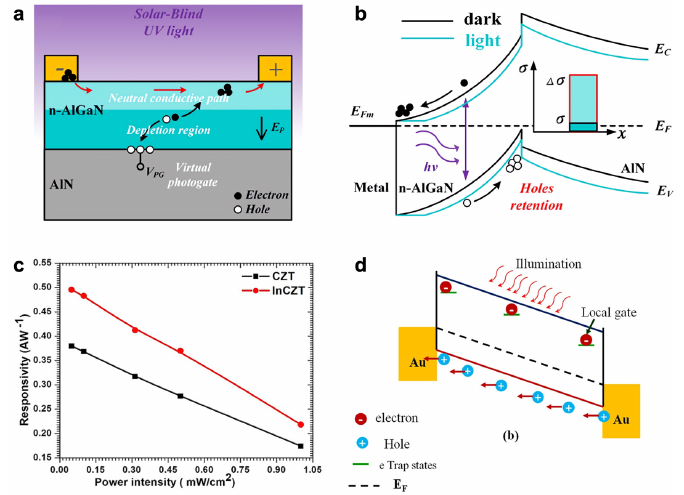
Figure 4. Inorganic compound-based photodetector. ( a ) Schematic diagram of an Al 0.5 Ga 0.5 N ∕ AlN solar-blind UV photodetector and its neutral conductive path under DUV irradiation. ( b ) Schematic diagram of the energy band under dark and illumination conditions. ( c ) Measured and fitted pho- tocurrent of a CZT- and InCZT-based device under different intensities of light irradiation. ( d ) Sche- matic of the band diagram of the device under light illumination. ( a , b ) Reproduced with permission from [113]. Copyright Chinese Laser Press, 2022. ( c , d ) Reproduced with permission from [116]. Cop- yright American Chemical Society, 2019.